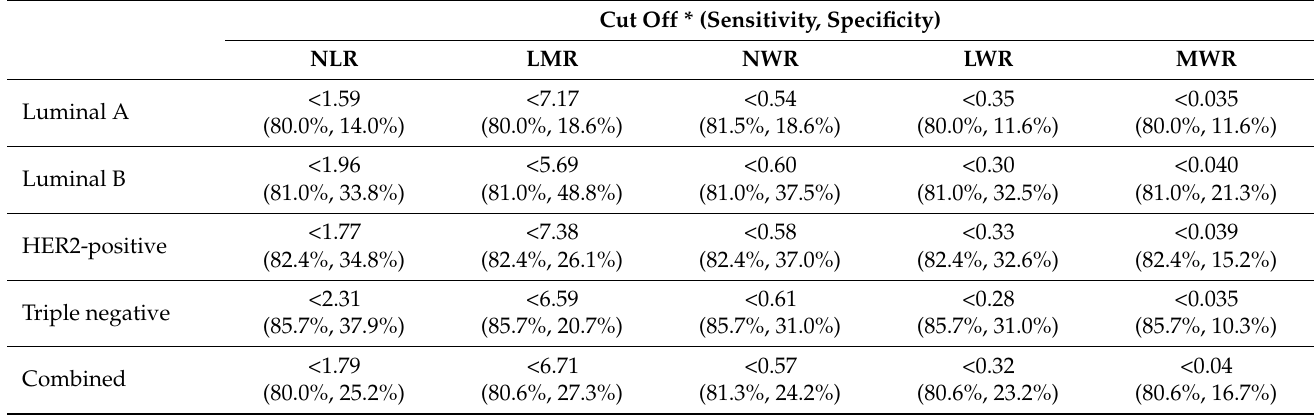
Table 6. Optimal immunocyte ratio cut-off values by cancer subtype for 3-year DFS.